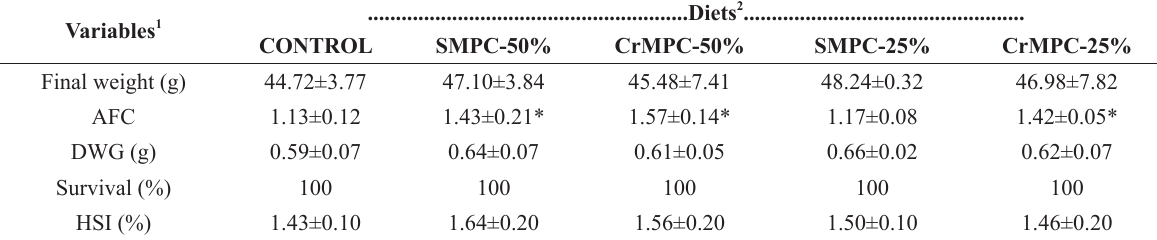
Growth parameters, survival and hepatosomatic index of silver catfish juveniles of different experimental groups fed different experimental